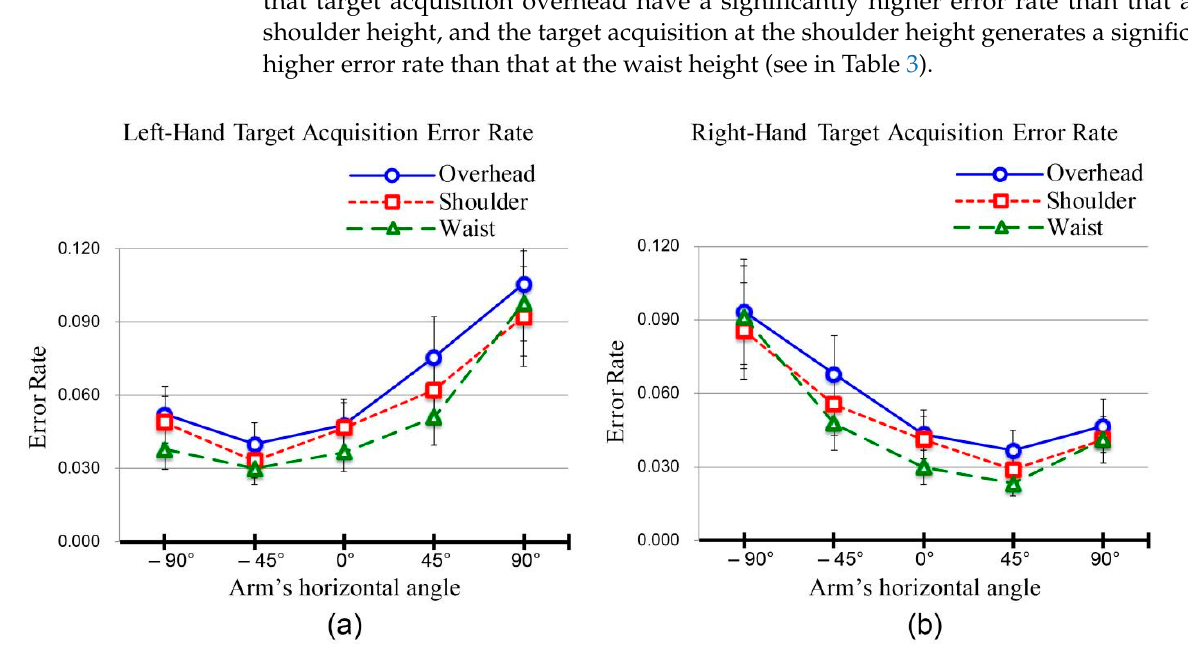
Figure 7. An illustration about the end-point’s offset or scatter from the target’s actual position. According to Equation (3), the end-point scatter reflected the integrated offset in three directions. We used a visualized diagram to present the end-point scatter result at different positions by either hand, shown in Figure 8. The diameter of the circles reflects the standard deviation of scatters, the center of circles refers to the averaged position of end-points and the black line indicates the offset from the end-points’ average position to the target’s actual position. A larger circle represents the end-points being more scattered, and the target acquisition being less accurate.